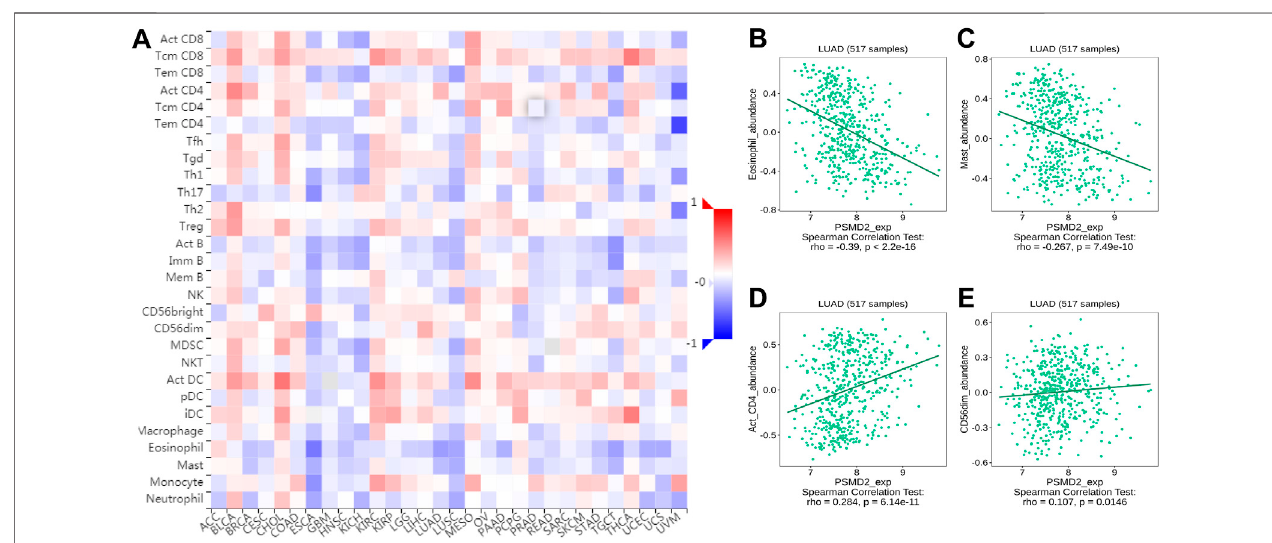
FIGURE 10 | The relations between PSMD2 expression and abundance of TILs in TISIDB. (A) Relations between PSMD2 expression and 28 types of TILs across human cancers. (B – E) Scatter diagrams for correlation between PSMD2 expression and abundance of eosinophil cells, mast cells, activated CD4 cells, and CD56dim